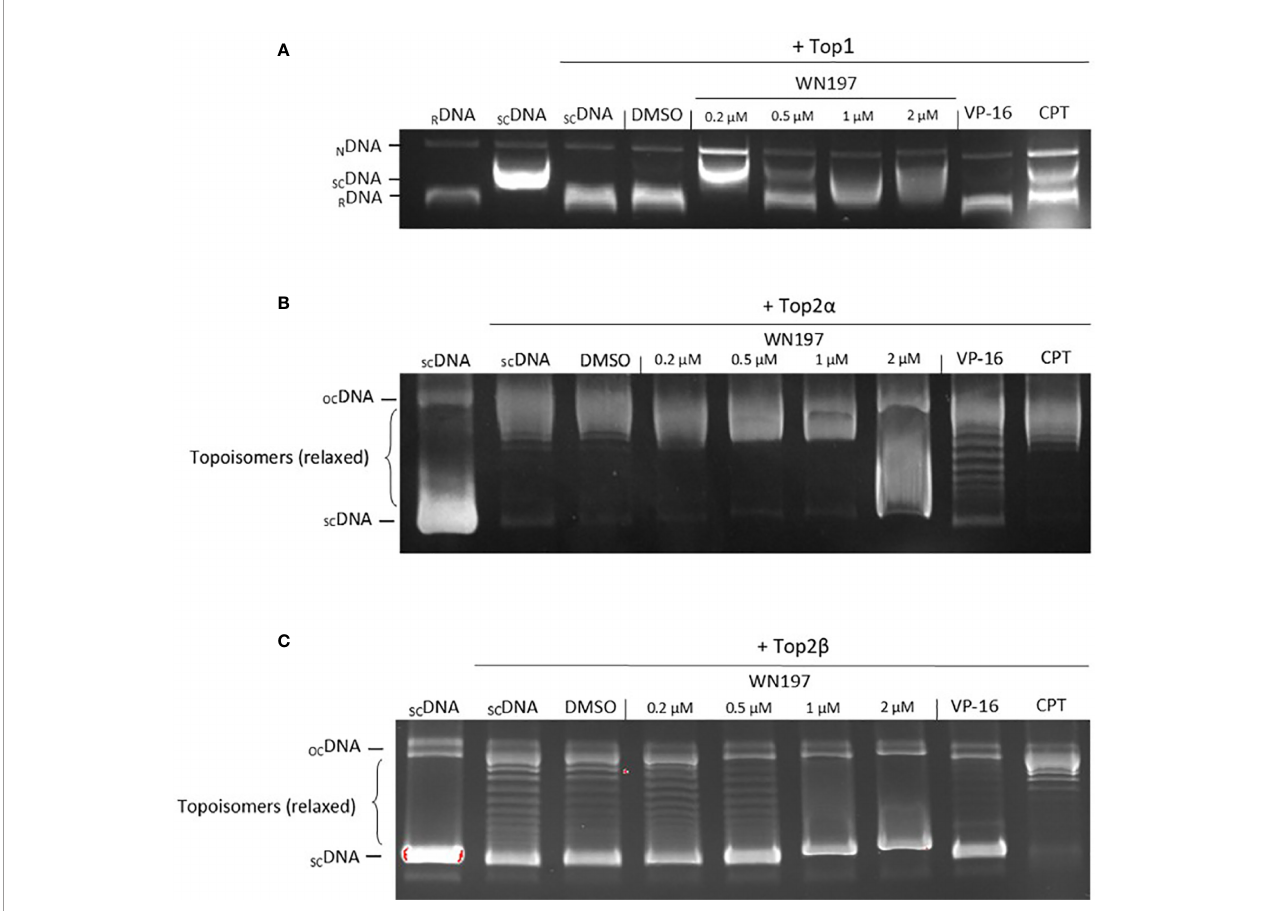
FIGURE 3 | WN197 inhibited human topoisomerase activity in a dose-dependent manner. (A) Top1 activity was determined by in vitro assays after addition of either DMSO (5%, solvent control, lane 4), WN197 at different concentrations (0.2, 0.5, 1 and 2 µM, lanes 5-8), etoposide (VP-16, 50 µM; Top2 poison, lane 9) the negative control of Top1 activity inhibition, or camptothecin (CPT, 10 µM; Top1 poison, lane 10) the positive control of Top1 activity inhibition. Relaxed DNA ( R DNA, lane 1) or supercoiled DNA ( SC DNA, lane 2) were used as migration controls. SC DNA was used in all other reactions in presence of Top1. The Top1 activity control allowing the relaxation of SC DNA is in lane 3. The addition of proteinase K allowed detection of nicked DNA ( N DNA), a witness of the single-strand broken DNA stabilization by a topoisomerase poison. (B) Top2 a activity inhibition assay. Migration control of supercoiled DNA ( SC DNA) was performed in lane 1. Top2 a was present in all other reactions. The Top2 a activity control for the relaxation of SC DNA is in lane 2, the fi rst band corresponds to the transitional open circular DNA ( OC DNA) and topoisomers correspond to the relaxed DNA. DMSO (5%, solvent control) in lane 3, WN197 (concentrations of 0.2, 0.5, 1 and 2 µM) in lanes 4-7, etoposide (VP-16, 50 µM; Top2 poison) in lane 8, and camptothecin (CPT, 10 µM; Top1 poison) in lane 9. (C) Top2 b activity inhibition assay. Migration control of SC DNA was performed in lane 1. Top2 b was present in all other reactions. The Top2 b activity control for the relaxation of SC DNA is in lane 2, DMSO (5%, solvent control) in lane 3, WN197 (concentrations of 0.2,